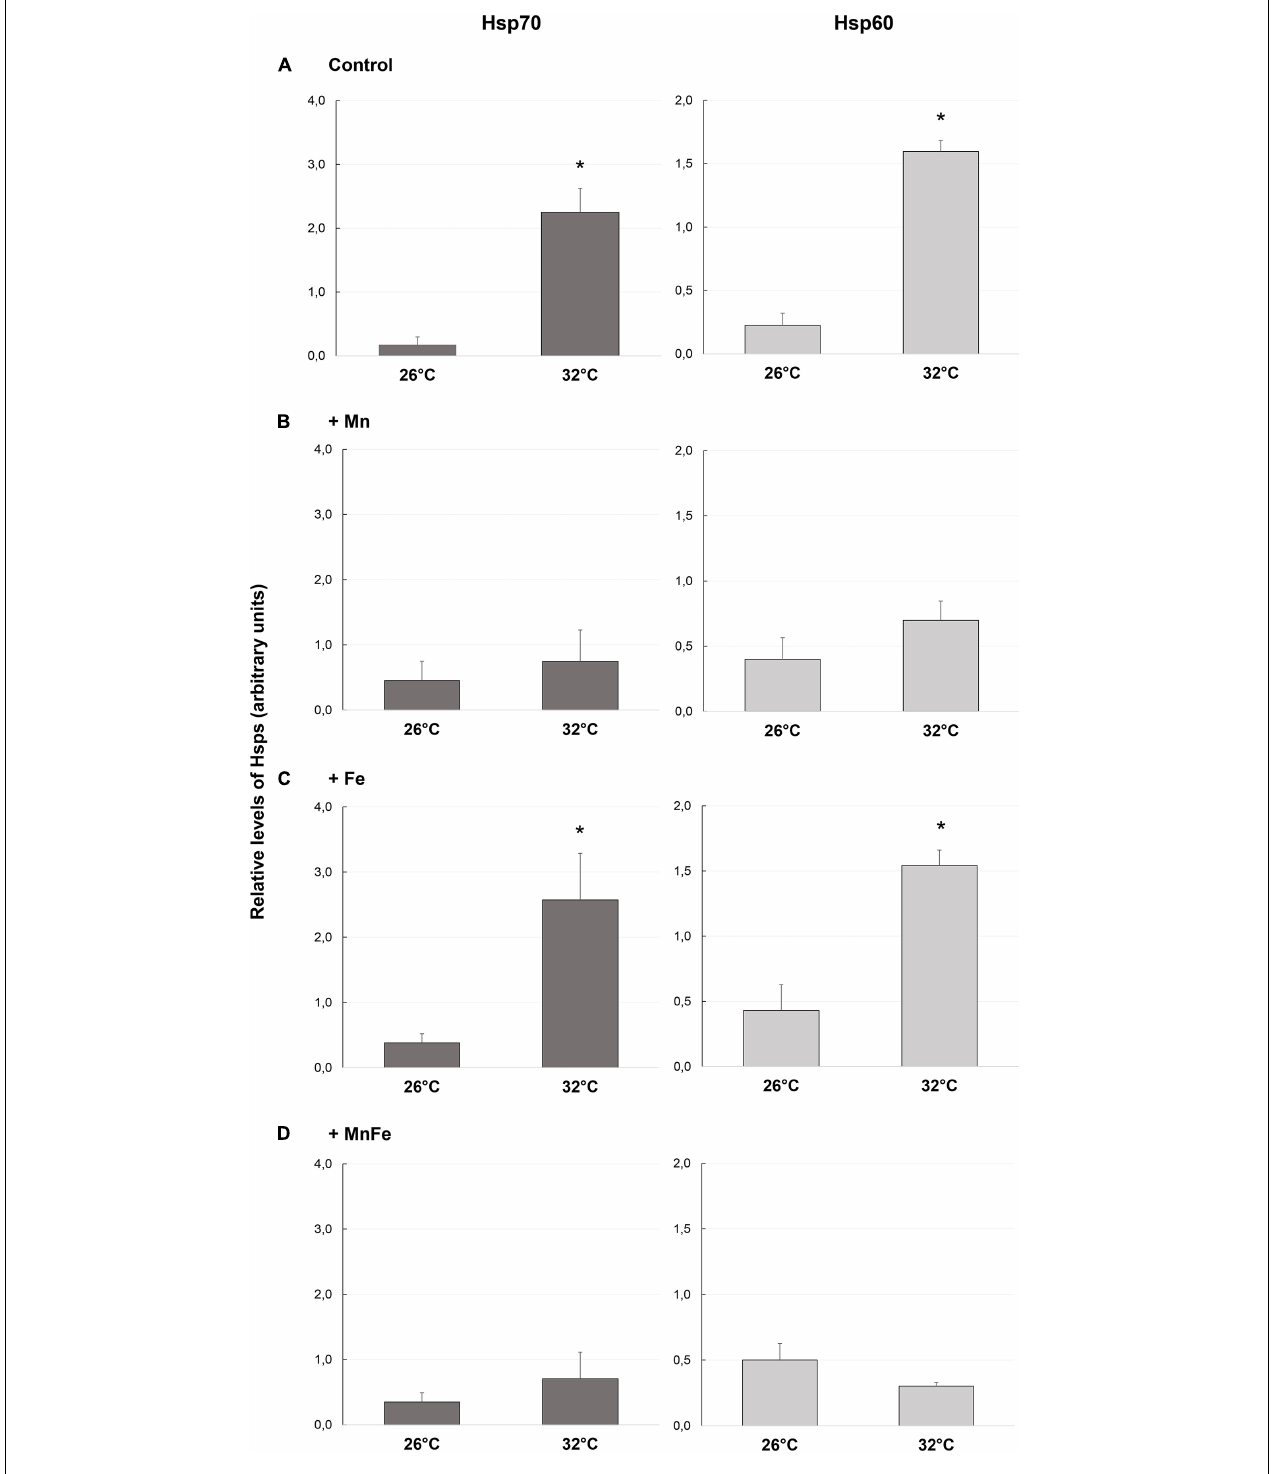
FIGURE 1 | Levels of Hsp70 and Hsp60 detected in samples of S. pistillata exposed to the different metal treatments ( A : Control; B : +Mn; C : +Fe; D : +MnFe) after 6 weeks at 26 ◦ C or 3 weeks at 32 ◦ C. The values were determined by densitometric analysis as described under section “Materials and Methods.” In the same section, the values related to the metal concentrations for each treatment are also shown. Data are expressed as arbitrary units and as mean ± SEM ( n = 4, for both Hsp70 and Hsp60). For each biomarker, asterisks indicate significant differences between corals maintained at 26 and 32 ◦ C under different treatments and, within each treatment, between corals maintained at 26 and 32 ◦